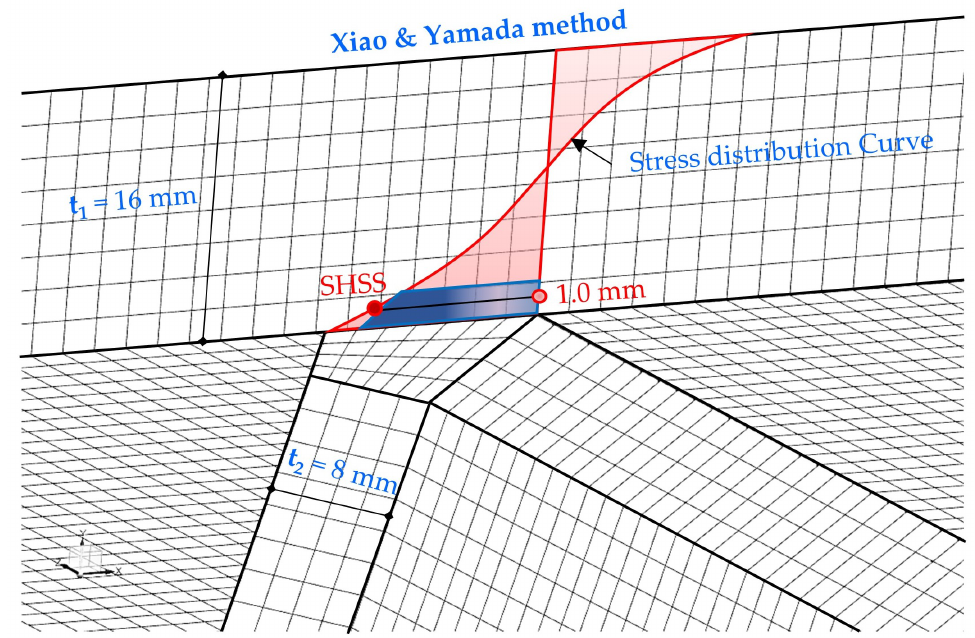
Figure 4. Xiao and Yamada method for evaluation of SHSS at weld-toe with 2.0 mm CHEXA20